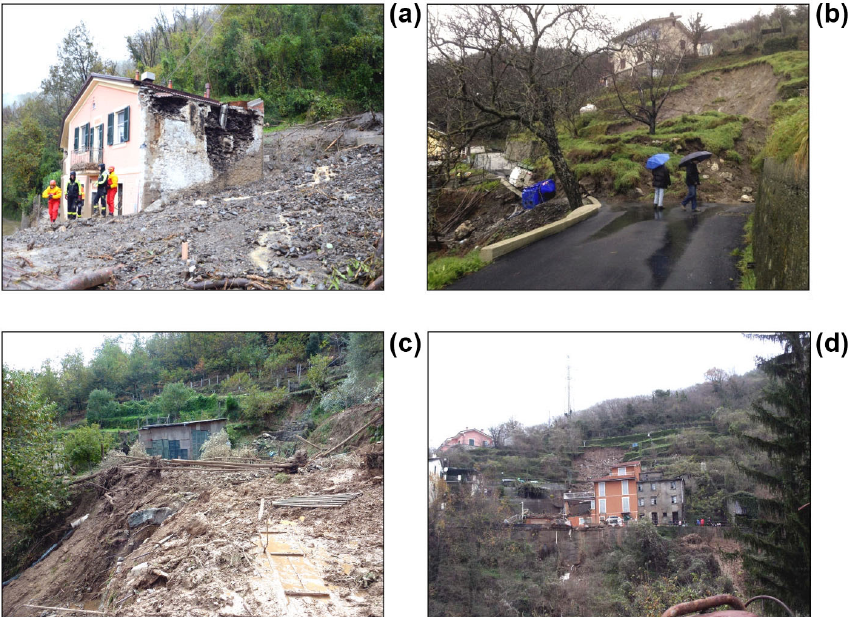
Figure 2. Example of shallow landslides triggered by intense rainfall in the Entella catchment in the 15-year period 2002–2016. (a) Leivi: view of an earth flow that destroyed a building, causing two casualties, on 10 November 2014. (b) Ne: view of a shallow landslide that occurred on 4 January 2014. (c) Mezzanego: damage to a road and private property caused by a shallow landslide on 22 October 2013. (d) San Colombano Certenoli; view of an earth flow that damaged a building on 24 November 2002. See Fig. 1 for location of the landslide